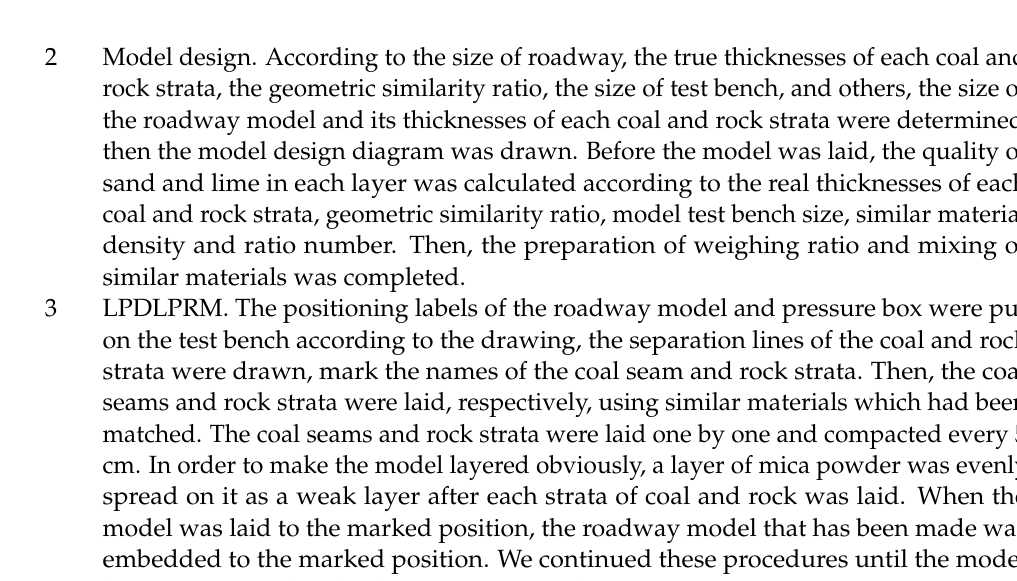
Table 1. Similar material ratio and mechanical parameters.